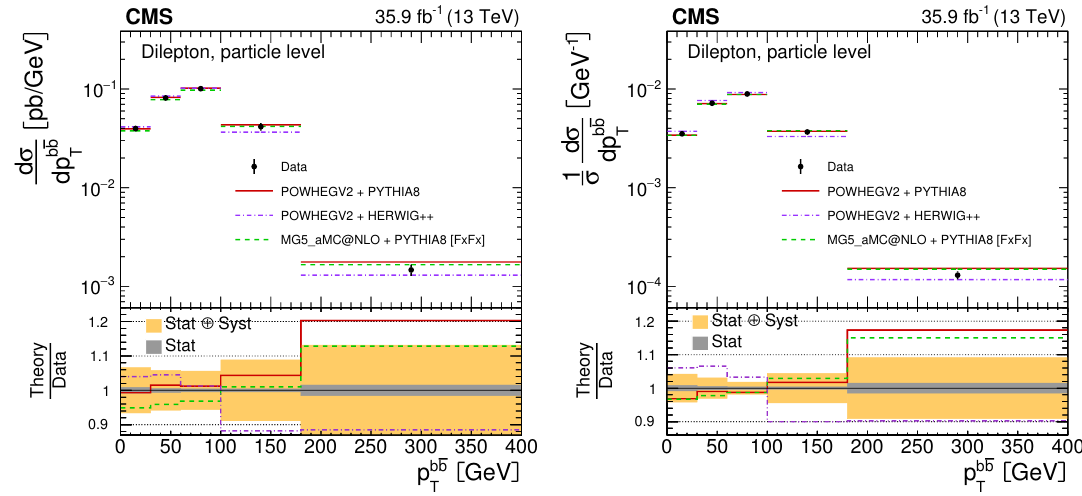
Figure 49 . The di(cid:11)erential tt production cross sections as a function of p bb space at the particle level are shown for the data (points) and the MC predictions (lines). The vertical lines on the points indicate the total uncertainty in the data. The left and right plots correspond to absolute and normalised measurements, respectively. The lower panel in each plot shows the ratios of the theoretical predictions to the data. The dark and light bands show the relative statistical and total uncertainties in the data, respectively.